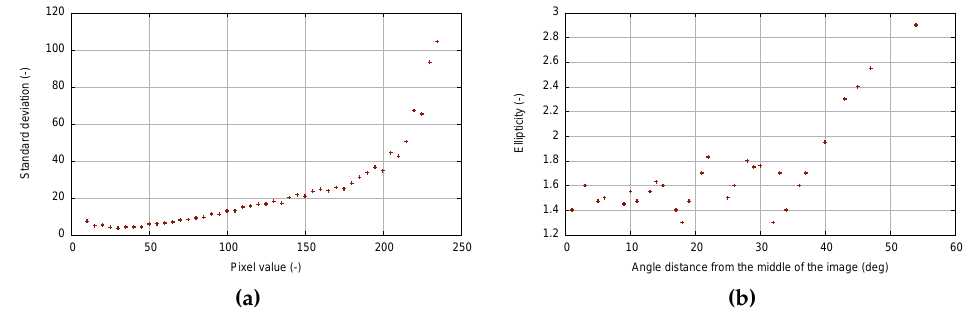
Figure 4. ( a ) Pixel value standard deviations; ( b ) Ellipticity of stellar objects.